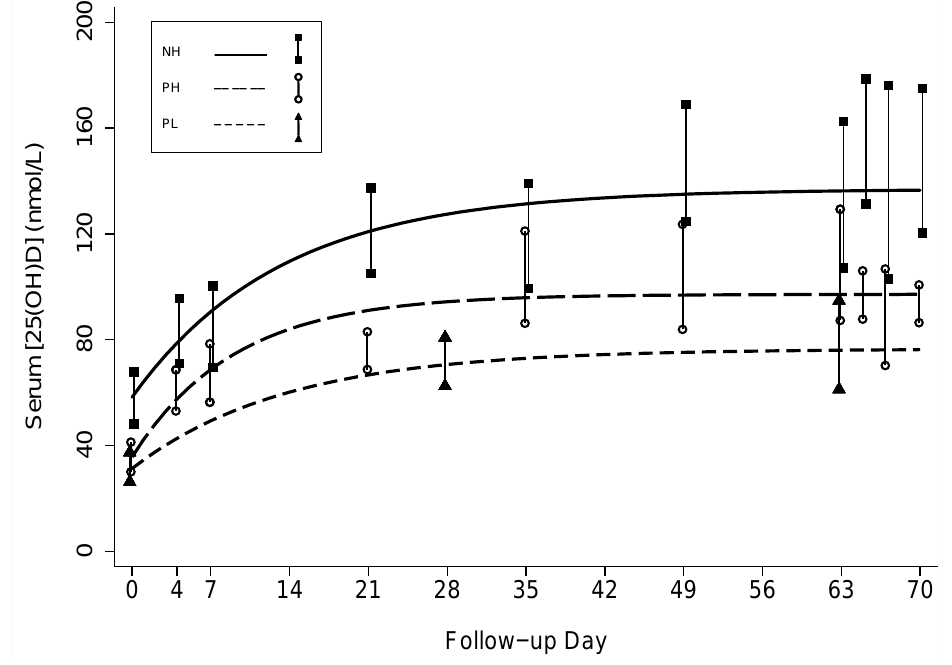
Figure 5. Negative exponential models predicting serum 25-hydroxyvitamin D concentrations in response to weekly vitamin D3 supplementation in non-pregnant